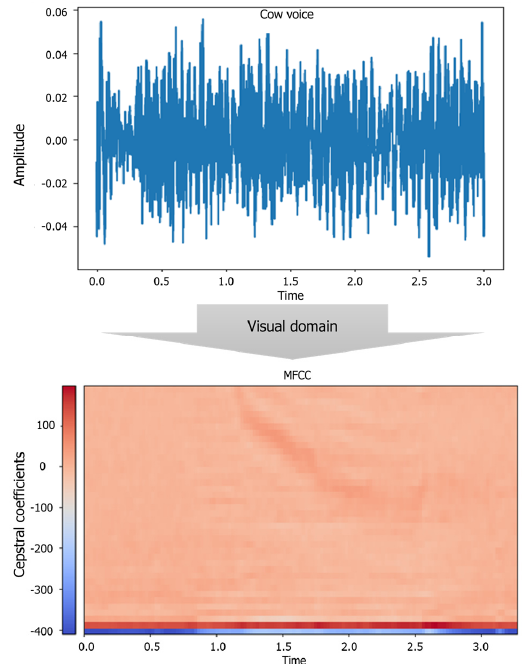
Figure 4. The conversion of sound information into cepstrum form using Mel-scale filter. 2.3.2. CNN Model for Removing External Sounds A deep learning classification model was developed for classifying cattle voices and other noise samples generated in the barn environment. The sounds of the livestock envi- ronment generated at this time include noises of the microphone itself, the operation sound of the livestock farm machinery, metal clanging, bird chirping, dialog between farm workers, barking of a dog, and various other sounds. For the recorded samples, a total of